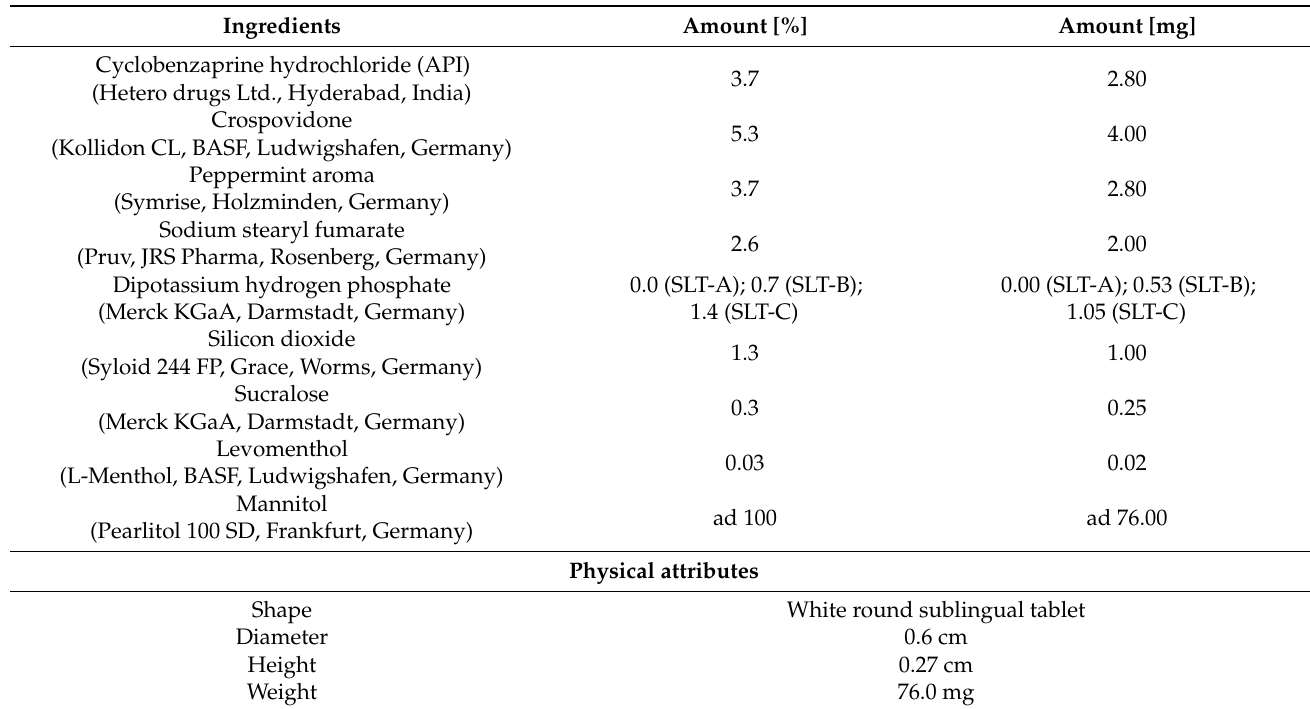
Table 2. Compositions of sublingual tablets. API, Active pharmaceutical ingredient; SLT, Sublingual tablet.